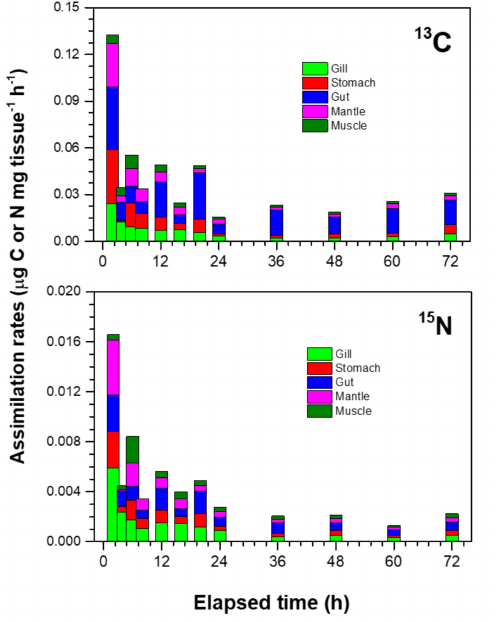
Figure 6. Assimilation rate of carbon and nitrogen in various tissues after introduction of Unio douglasiae in Microcystis -predominating waters for 72 h. Each value is the average of three subsamples (standard errors are not